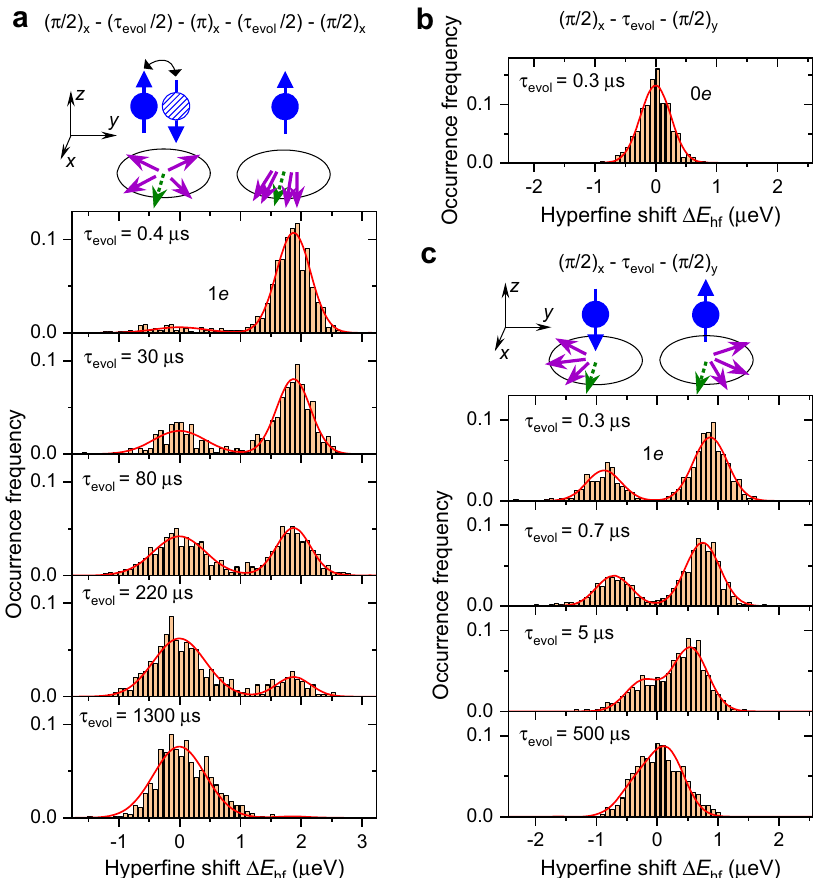
Fig. 3 Single-shot NMR detection of the electron spin state. a Spin echo of 75 As nuclei in a t B = 37 nm sample at B z ≈ 7.8 T measured with a single-shot optical detection of the resulting hyper fi ne shift variation Δ E hf . Measurement rf pulse sequence is ( π /2) x − ( τ evol /2) − ( π ) x − ( τ evol /2) − ( π /2) x with several values of the total free evolution time τ evol = 0.4 − 1300 μ s shown. Results are plotted as histograms of the detected single-shot spin echo amplitudes Δ E hf . Lines show double Gaussian fi ts. Schematic shows electron spin in an s z = + 1/2 or − 1/2 states (balls with up or down arrows). After the initial ( π /2) x pulse all nuclear spins point along the same axis orthogonal to z (dashed small arrow) and then precess around the z axis to point along generally different directions (solid small arrows) prior to the fi nal ( π /2) x pulse: An electron spin- fl ip during the nuclear spin precession dephases the spins, resulting in Δ E hf ≈ 0, whereas in the absence of electron fl ips, nuclear spin echo is formed, resulting in Δ E hf ≈ 1.9 μ eV. b Single-shot measurement of the free induction decay in an empty QD (0 e ), using sequence ( π /2) x − ( τ evol ) − ( π /2) y , where subscripts x , y denote the equatorial axes in the rotating frame towards which the spins are fl ipped by the rf pulses. Line shows Gaussian fi t. c Same sequence as in ( b ) applied to a charged QD (1 e ). For a suf fi ciently short evolution time τ evol ≲ T (cid:4) ; ð 1 e Þ the spin s z = − 1/2 ( s z = + 1/2) of a single-electron pointing down (up) gives rise to a negative (positive) quadruature 2 ; N nuclear spin polarization Δ E hf , observed as a bimodal distribution of the single-shot-detected Δ E hf . Lines show double Gaussian fi